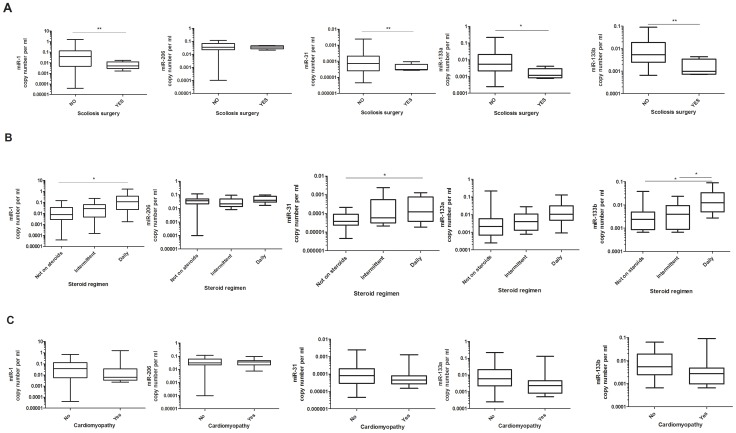
Serum level of the analysed dystromirs in DMD patients according to clinical variables.Level of miR-1, miR-206, miR-31, miR-133a and miR-133b in serum samples of DMD patients: A. without the need of scoliosis surgery and with scoliosis surgery performed or recommended; B. not on glucocorticoid treatment, on intermittent or on daily steroid regimen; C. without cardiomyopathy and with cardiac abnormality. The data are presented in a logarithmic scale as miRNA copy number per ml normalized to the spiked-in C. elegance miRNAs (cel-miR-54, cel-miR-39, cel-miR-238). P-values derived from t-test are presented with *, ** and correspond to p <0.05 and p<0.01 respectively.